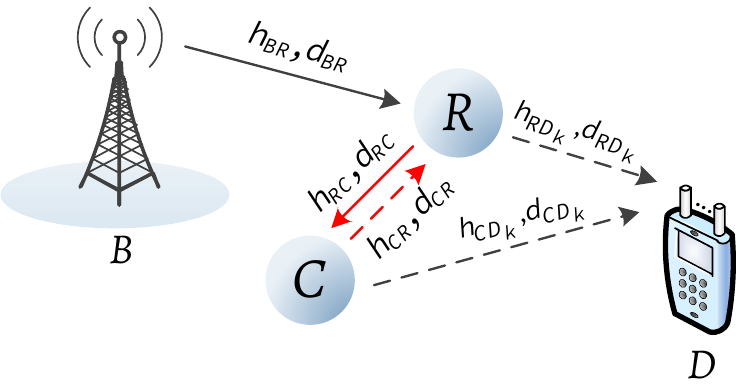
Figure 1. System model of the proposed AmBC network which comprises a base station B , a relay R , an AmB transceiver node C and a K -antenna destination D